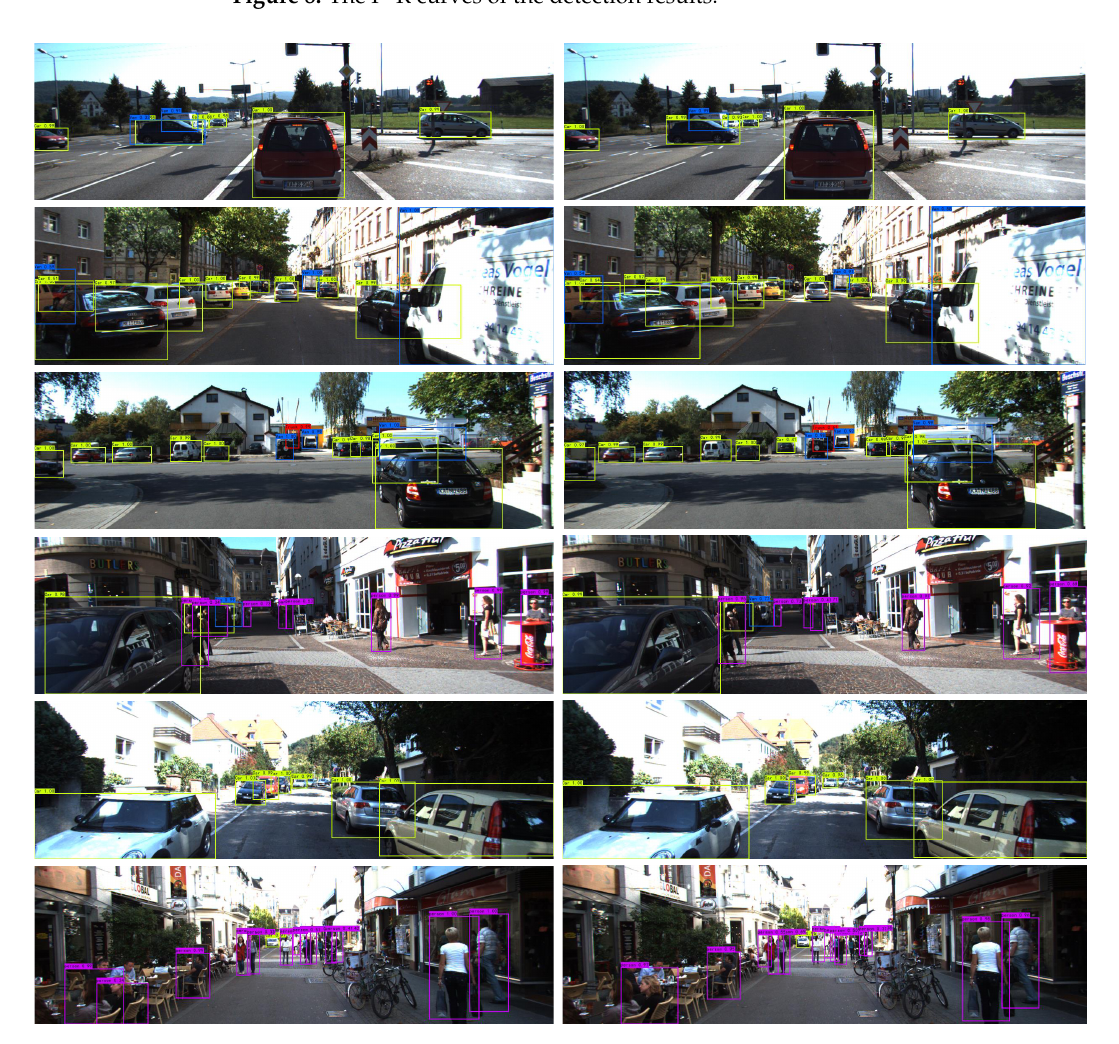
Figure 9. The visualization of